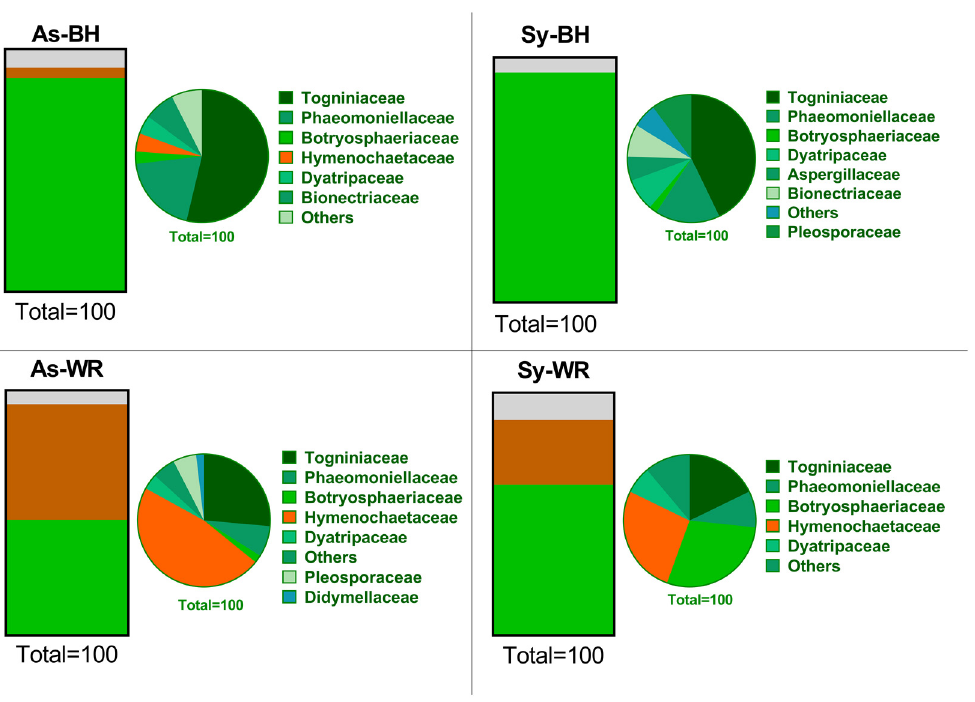
Figure 2. Relative abundance of fungal phyla and families resulting from culture-dependent microbiological analysis. Green color represents phylum Ascomycota, orange color represents phylum Basidiomycota, and gray color represents “unknown”.